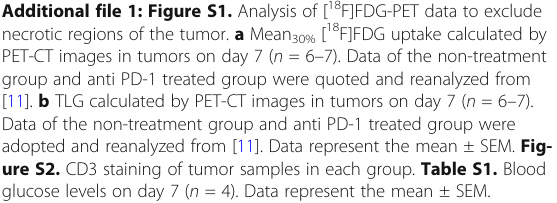
Additional file 1: Figure S1. Analysis of [ 18 F]FDG-PET data to exclude necrotic regions of the tumor. a Mean 30% [ 18 F]FDG uptake calculated by PET-CT images in tumors on day 7 ( n = 6 – 7). Data of the non-treatment group and anti PD-1 treated group were quoted and reanalyzed from [11]. b TLG calculated by PET-CT images in tumors on day 7 ( n = 6 – 7). Data of the non-treatment group and anti PD-1 treated group were adopted and reanalyzed from [11]. Data represent the mean ± SEM. Fig- ure S2. CD3 staining of tumor samples in each group. Table S1. Blood glucose levels on day 7 ( n = 4). Data represent the mean ±